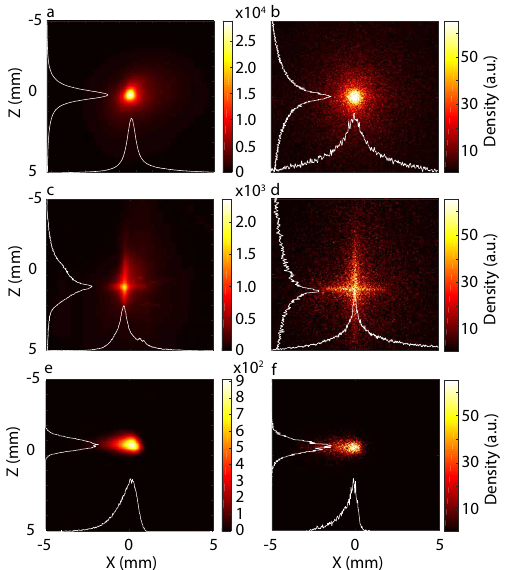
Figure 15. Transverse beam shape at the undulator entrance: measurements ( a , c , e ) and simulations = 2 mrad and σ (cid:48) = 3.12 mrad, (cid:101) ( b , d , f ) with the low skew a 2 case (Table 2), σ (cid:48) z , i , (cid:101) x , i = 0.2 mm.mrad. z , i x , i ( a , b ) “Undulator entrance” optics, QUAPEVA 1: 103.27 T/m, QUAPEVA 2: − 115.65 T/m, QUAPEVA 3: 94.94 T/m, ( c , d ) QUAPEVA 1: 103.27 T/m, QUAPEVA 2: − 121.99 T/m, QUAPEVA 3: 94.94 T/m. ( e , f ) With the “slit-undulator” optics, a horizontal pointing of 5 mrad and the slit in the chicane closed at 1 mm (177 ± 2 MeV). Shot-to-shot pointing for ( a , c , e ): 0.005 ± 0.01 mrad, − 0.09 ± 0.06 mrad, and 0.17 ± 0.49 mrad (0.03 ± 0.02 mrad, 0.10 ± 0.08 mrad, − 0.18 ± 0.01 mrad) in the horizontal (vertical) direction.